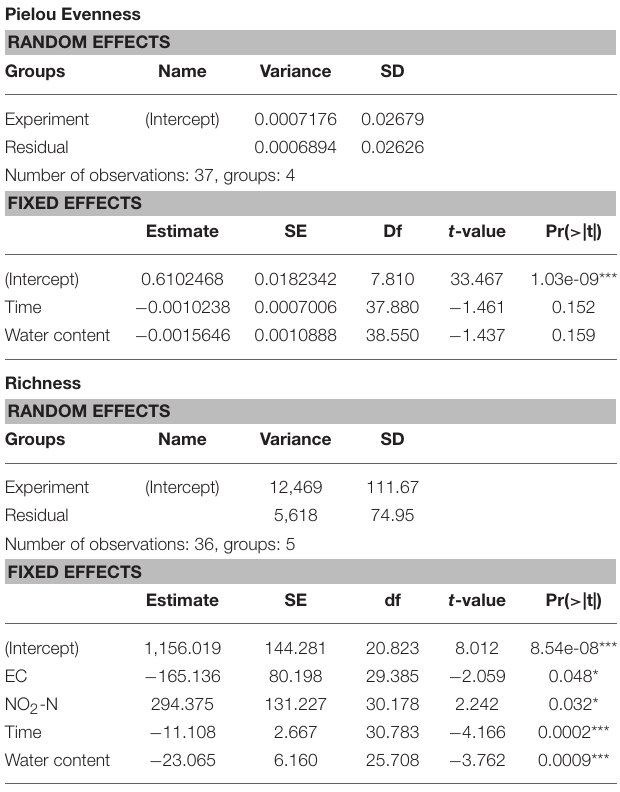
TABLE 2 | Results of linear mixed model of the effects of the measured physicochemical parameters and sampling time on community richness and